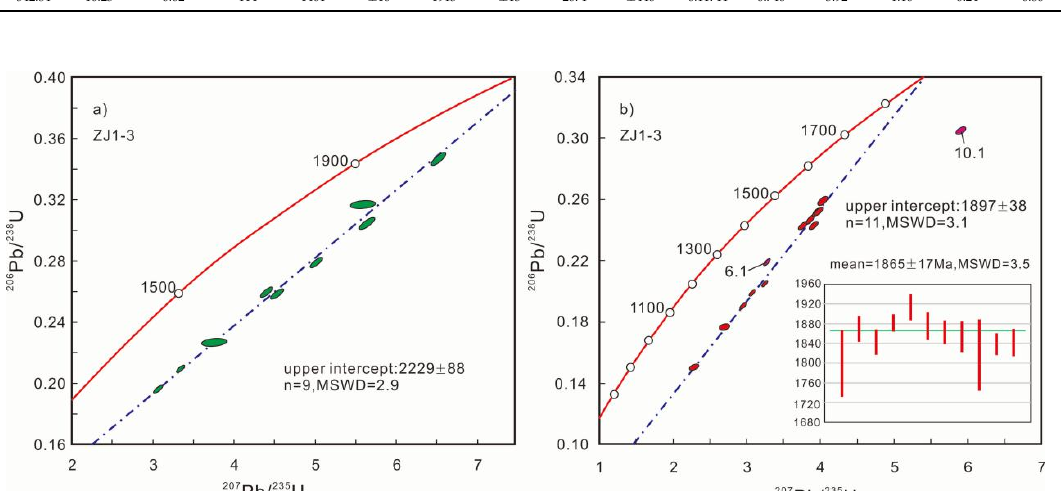
Figure 6. Concordia diagrams showing SHRIMP zircon data for the basement samples ZJ1-3: ( a ) for the magmatic zircons; ( b ) for the metamorphic overgrowths on zircon grains. Table 1. SHRIMP U-Pb analyses of zircons for granitic gneiss sample ZJ1-3 from drill cores ZJ-1 at northeastern Ordos Basin.